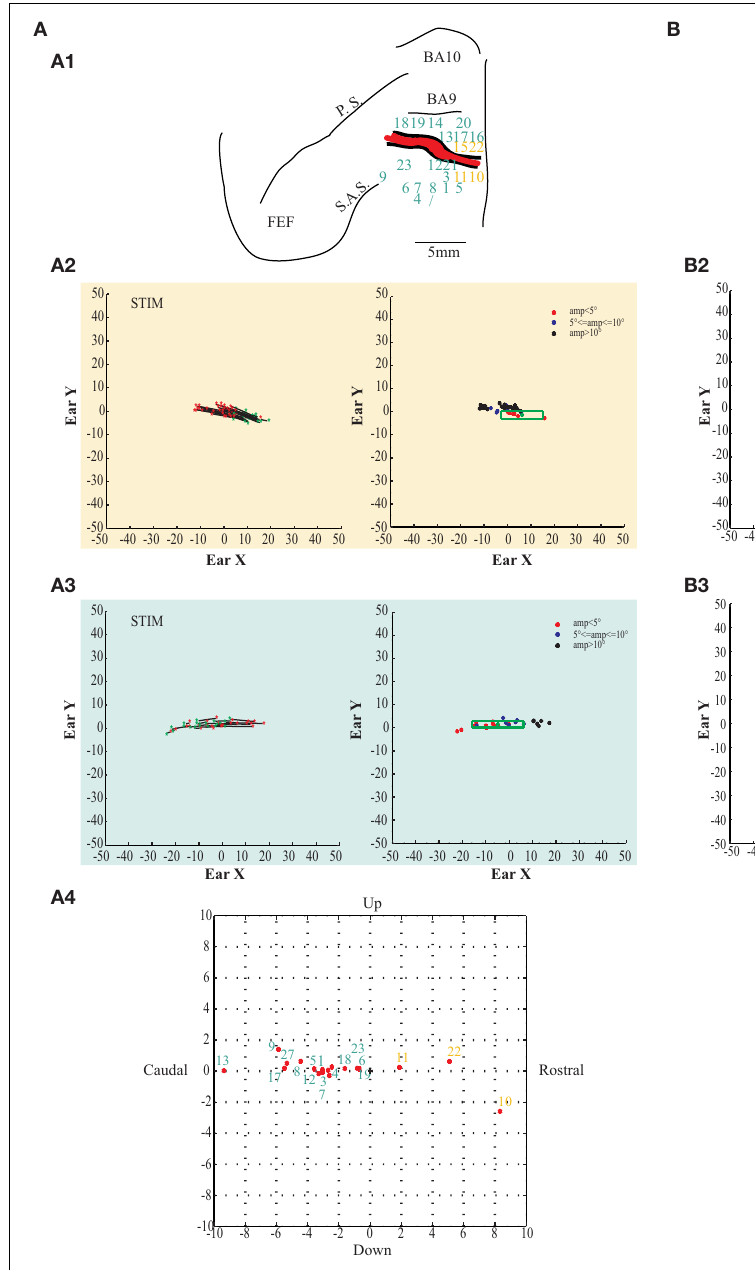
FIGURE 2 | Example of goal-directed ear movements. (A) The figures show data from monkey L. (A1) Map shows the locations of the electrode penetrations; yellow numbers represent penetrations of the core region, while aquamarine numbers represent penetrations of the belt region. Red thick line represents a superficial vessel which was avoided during the experimental sessions. FEF: Frontal Eye Field; SAS: Superior Arcuate Sulcus; PS: Principalis Sulcus; BA9: Brodmann Area 9; BA10: Brodmann Area 10. (A2) Example of goal-directed forward ear movements in the core region; red ∗ : starting position; green ∗ : final position. The plot on the left shows the direction of the ear movements. The plot on the right shows the relationship between starting position and movement amplitude. The green dot in the green square represents the averaged end-point with standard deviation (green square) (A3) Example of goal-directed backward ear movements in the belt region;